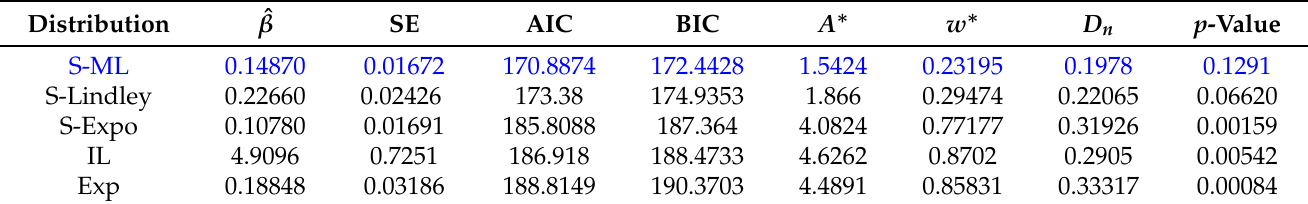
Table 3. ˆ β , SE and GOF metrics of the survival times of growth hormone